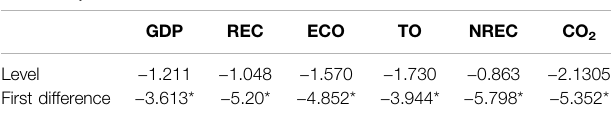
TABLE 5 | CIPS Test Outcomes.